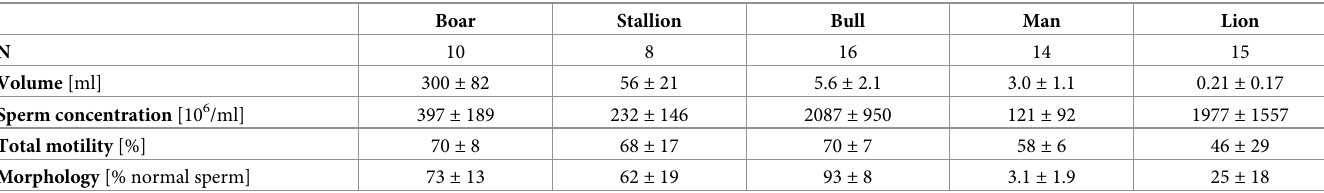
Table 1. Ejaculate and sperm parameters of the investigated species.